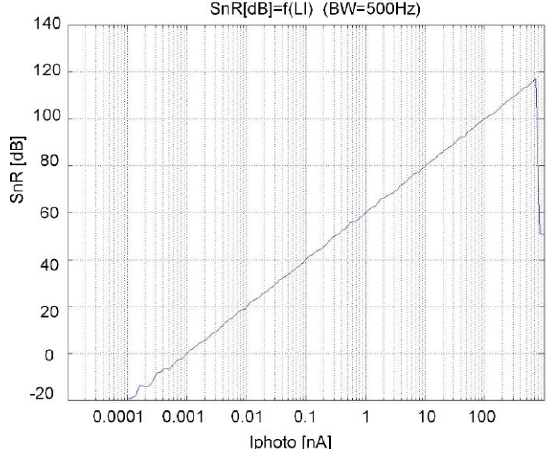
Figure 12. Circuit simulation result: SnR as a function of input light intensity with LF and HF choppers switched on.